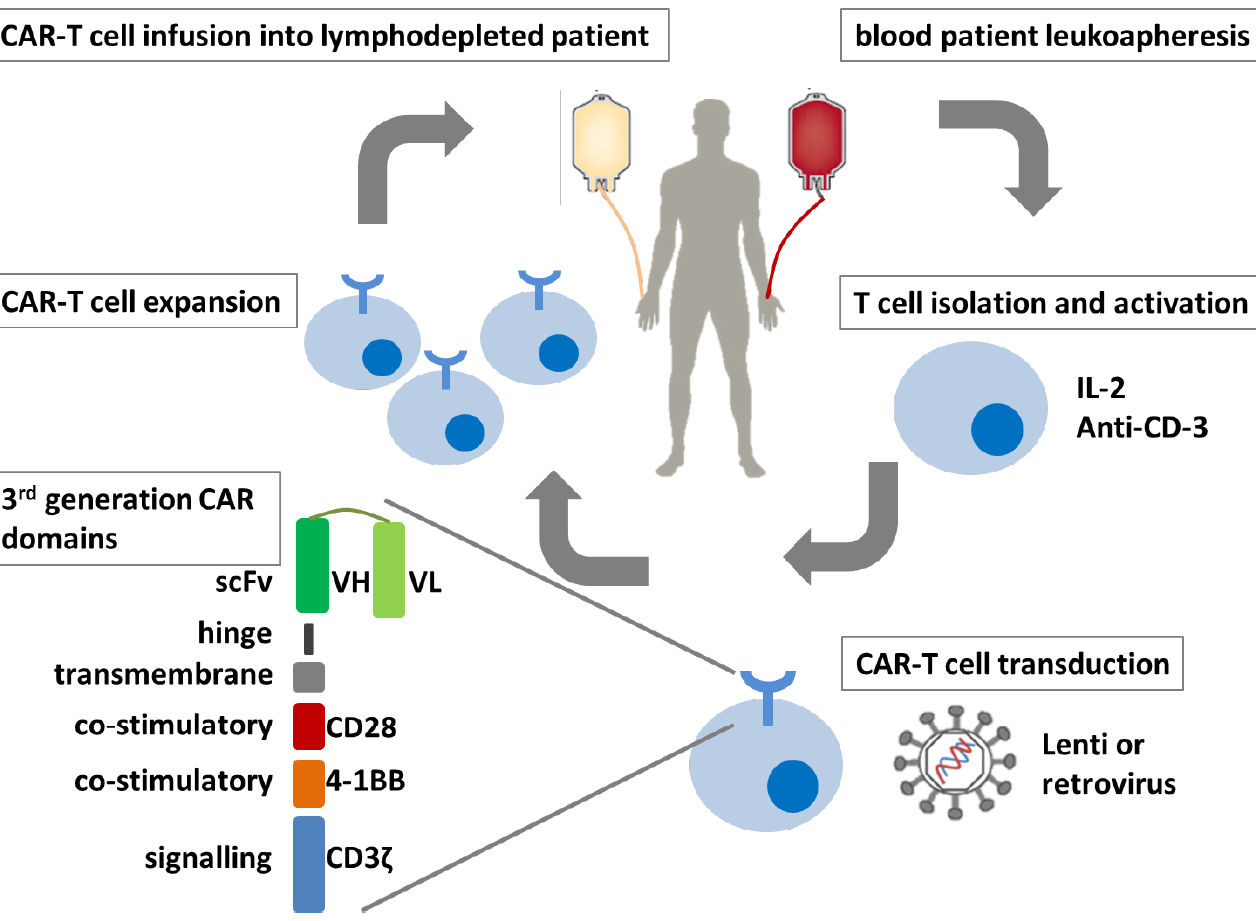
Figure 1. CAR-T cell therapy. Autologous T cells are modified with a third-generation CAR to be reinfused into the patient. CAR, chimeric antigen receptor; scFv, single-chain variable fragment VH, variable heavy chain; VL, variable light chain.